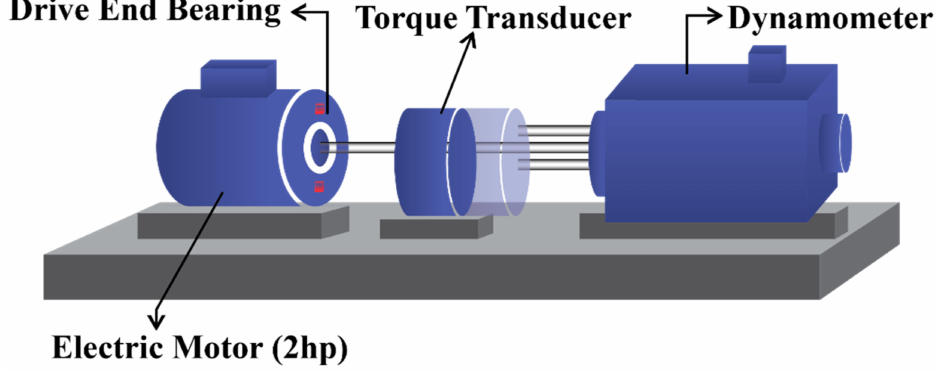
Figure 6. An overview of the experimental